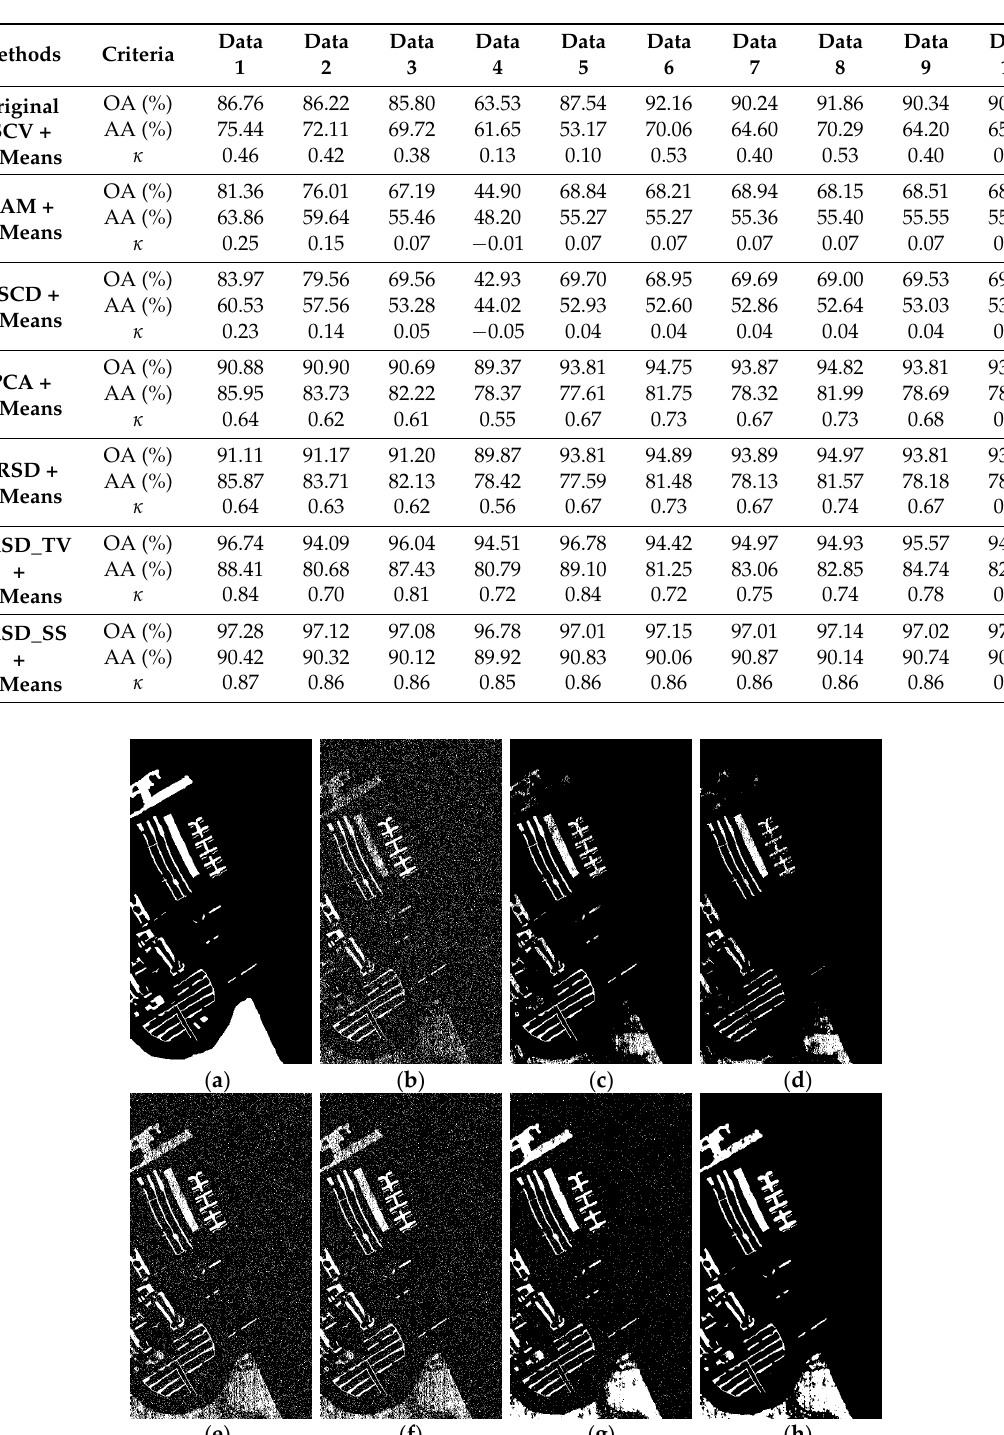
Table 1. Evaluation of change detection results for each type of the simulated bitemporal HSI.